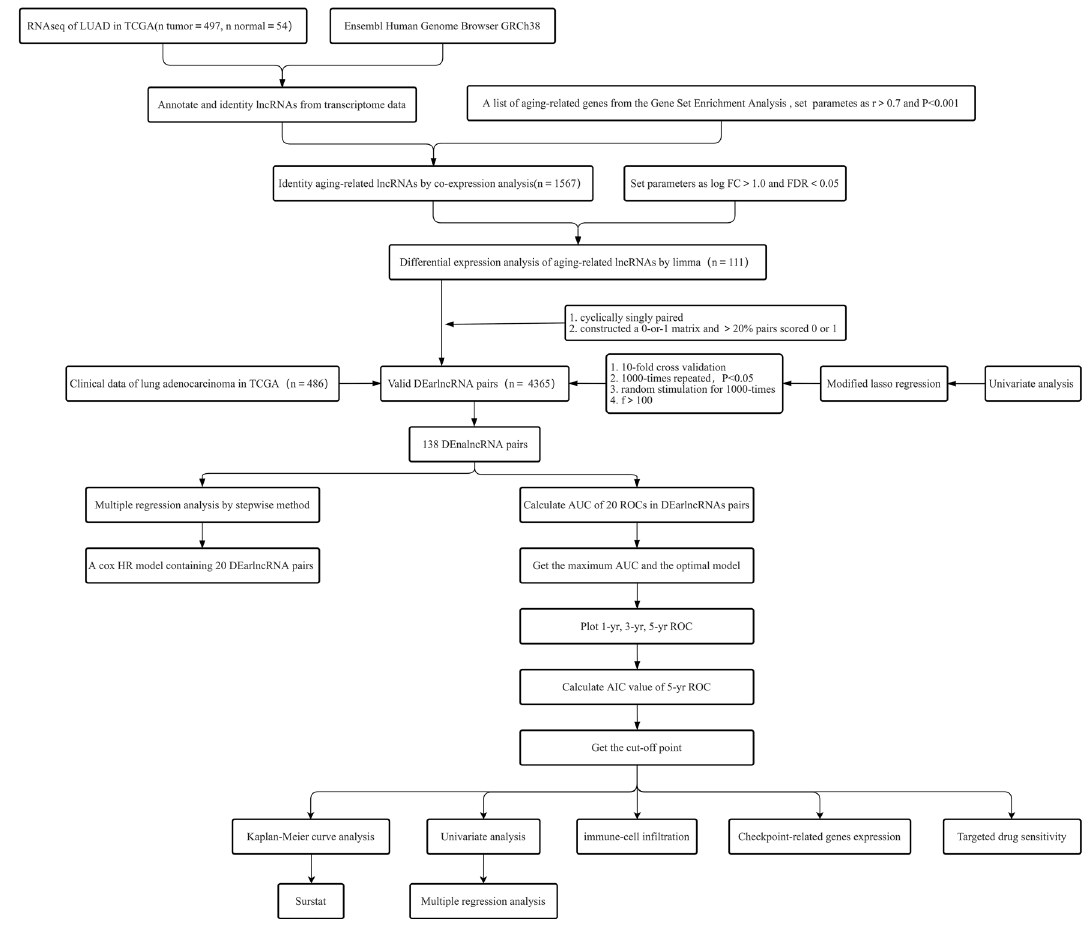
Figure 1. The study’s flow